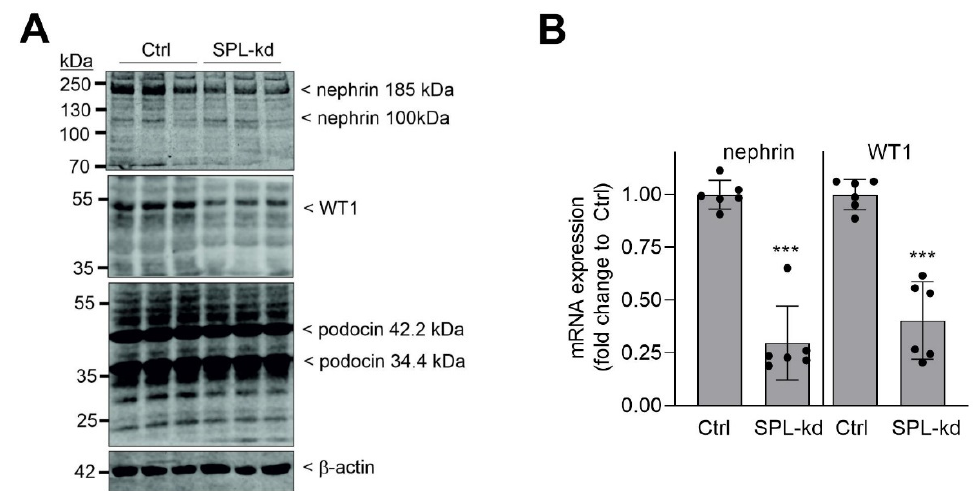
Figure 2. The effect of SPL-kd on nephrin and WT1 mRNA and protein expression in human podocytes. Human podocytes that were transduced with an empty vector (Ctrl) or a vector containing an SPL shRNA (SPL-kd), then differentiated to mature podocytes for 5 days at 37 °C, were incubated for 4 h in serum-free medium before the protein ( A ) and RNA ( B ) were extracted. Proteins were separated by SDS-PAGE, transferred to a nitrocellulose membrane, and subjected to Western blot analysis ( A ) of nephrin (top panel), WT1 (second panel), podocin (third panel) or β -actin (bottom panel). RNA were takenfor quantitative PCR analysis using the primers of human nephrin, WT1, and 18S RNA for normalization ( B ). Data in A show the details of one experiment performed in triplicate and is representative of at least three independent experiments. The bands corresponding to nephrin, WT1, podocin, and β -actin were evaluated using ImageJ software and are depicted in Supplementary Figure S2. The data in B are means ± SD ( n = 3). *** p < 0.001 is considered statistically significant when compared to the Ctrl samples.